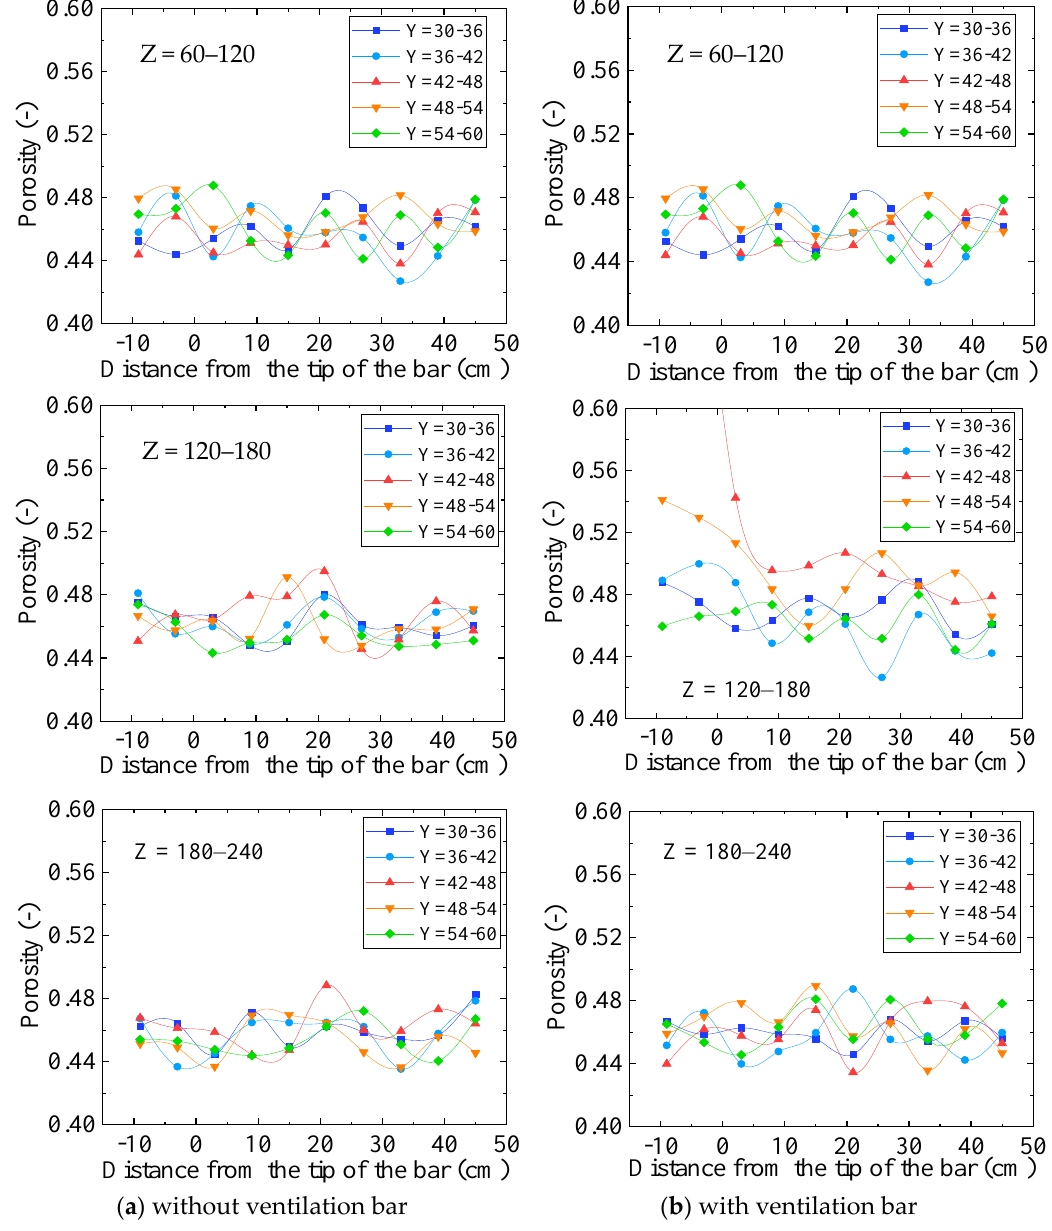
Figure 6. The porosity at each position of the packed bed.